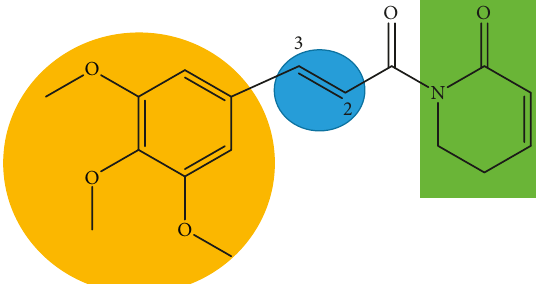
Figure 1: Chemical structure of piplartine ( 1 ). Modifications in the green and blue substructures of the molecule were investigated in the present